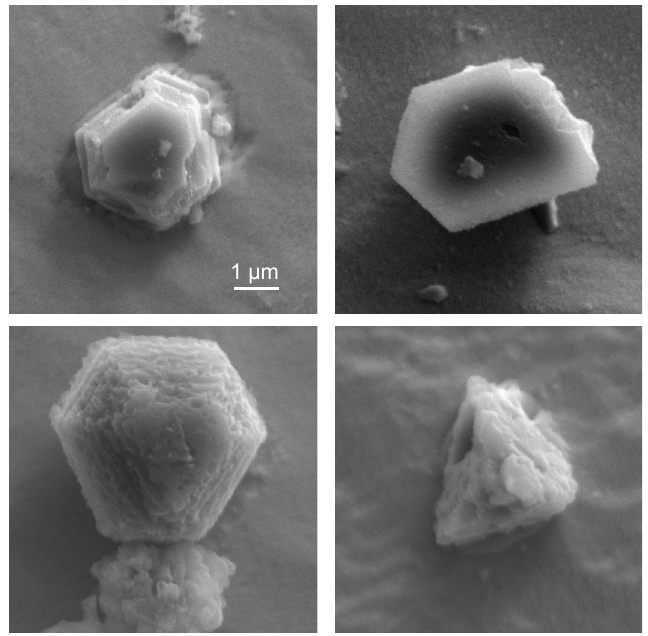
Figure 1. Scanning electron microscopic images of presolar SiC grains extracted from CM2 chondrite Murchison using the CsF acid dissolution method described in [37].